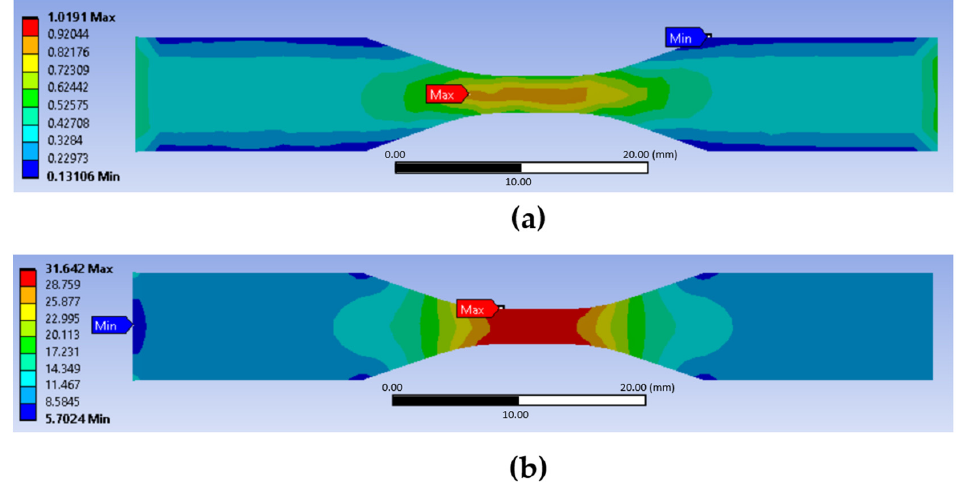
Figure 5. ( a ) Macroscopic failure indicator (MFI); and ( b ) equivalent stress (longitudinal orientation).